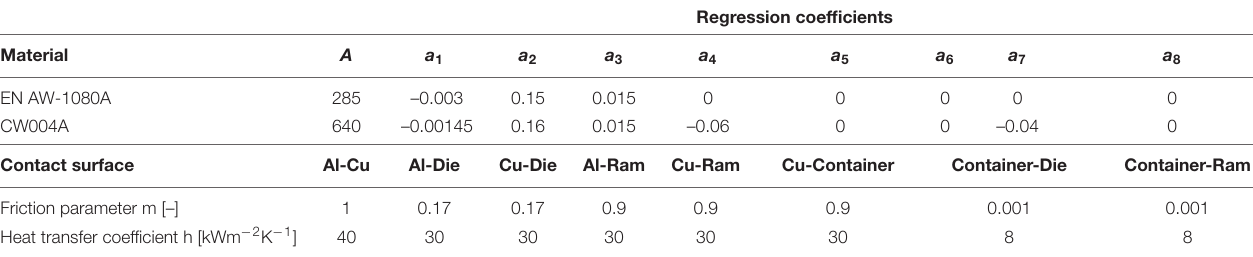
TABLE 1 | Regression coefficients of the Hensel-Spittel equation for the billet materials as well as friction parameters and heat transfer coefficients for the FE-analysis of the indirect extrusion.